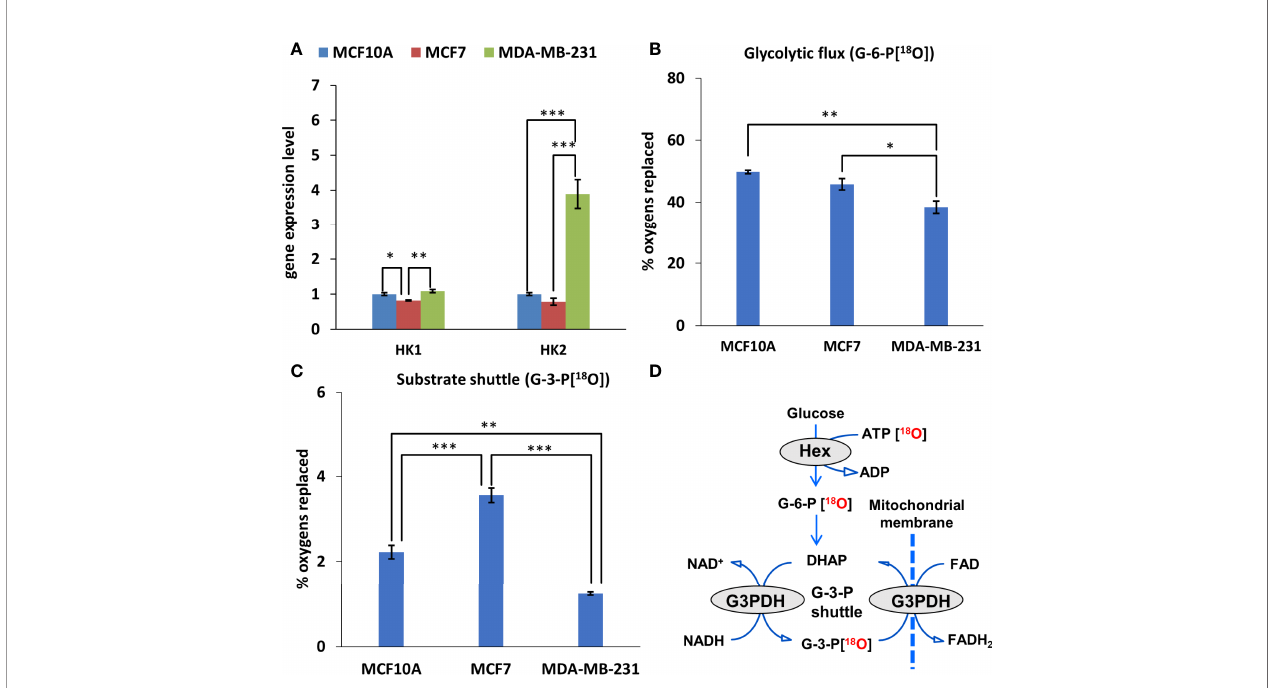
FIGURE 3 | Glycolytic and mitochondrial substrate shuttle pro fi le of Luminal A, Triple-negative breast cancer cells, and breast control cells. (A) HK (fold change of the mRNA level) isoform expression pattern in Luminal A (MCF7), Triple-negative (MDA-MB-231) breast cancer cells, and breast control cells (MCF10A). 18 O-metabolic labeling of (B) G-6-P [ 18 O] and (C) G-3-P[ 18 O] re fl ecting glycolytic and substrate shuttle activities, respectively. (D) Schematic representation of metabolite 18 O-labeling allowing for tracking glycolytic and G-3-P substrate shuttle dynamics. All data are presented as mean ± SEM (ANOVA followed by Holm-Sidak test n=3). *, ** and *** indicate statistically signi fi cant difference between the mean values, p < 0.05, p < 0.01, and p < 0.001, respectively. HK – hexokinase; G-6-P – glucose-6-phosphate; G-3-P –